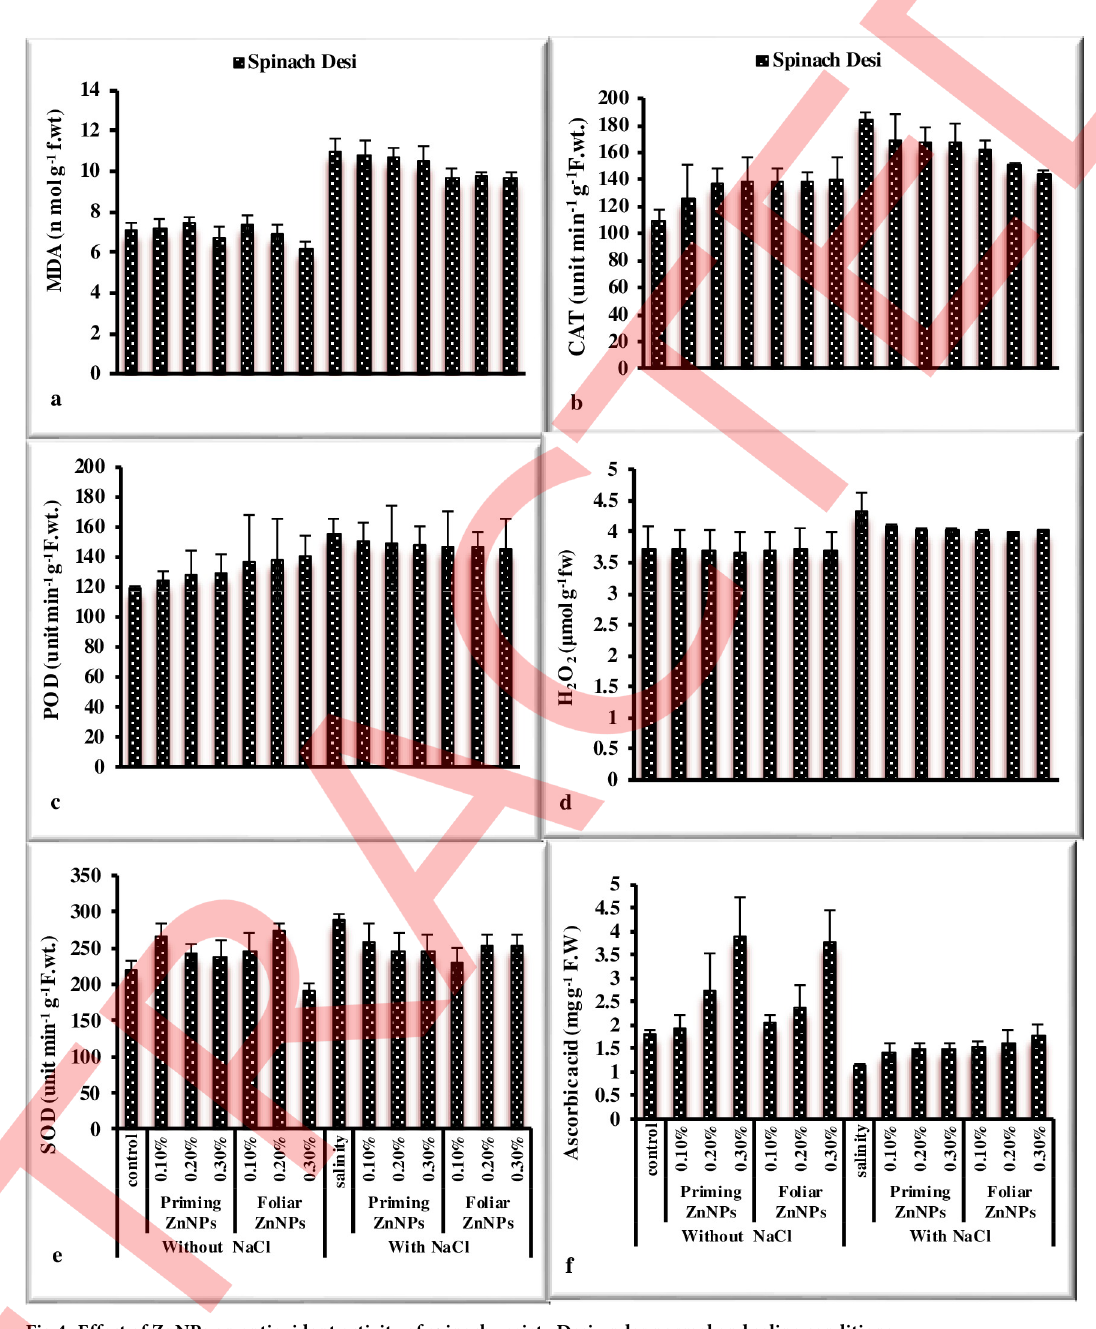
Fig 4. Effect of ZnNPs on antioxidant activity of spinach variety Desi under normal and saline conditions. indicator for the study of their vigor to tolerate salinity [46, 47]. It has been recorded that zinc nano-fertilization enhance agriculture output and provide resistance against abiotic stresses such as NaCl stress [24]. The experiment shows highly positive results of ZnNPs on the spin- ach plants. Shoot and root length was recorded highest at 0.3% foliar application of ZnNPs as reported by Afrayeem et al. [48]. Similarly, shoot fresh and dry biomass were noted highest by 0.3% foliar application of ZnNPs as compared to priming treatments. Root fresh and dry